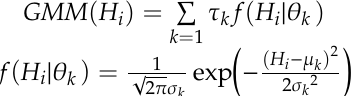
Figure 7. Diagram of Gaussian Mixture Model (GMM) distribution. The red curve is the GMM; the black curve is the projection curve (H); and Gauss 1, Gauss 2, and Gauss 3 (the "+" curve) are the components of the GMM. 3.3.1. EM Algorithm for GMM Parameter Estimation